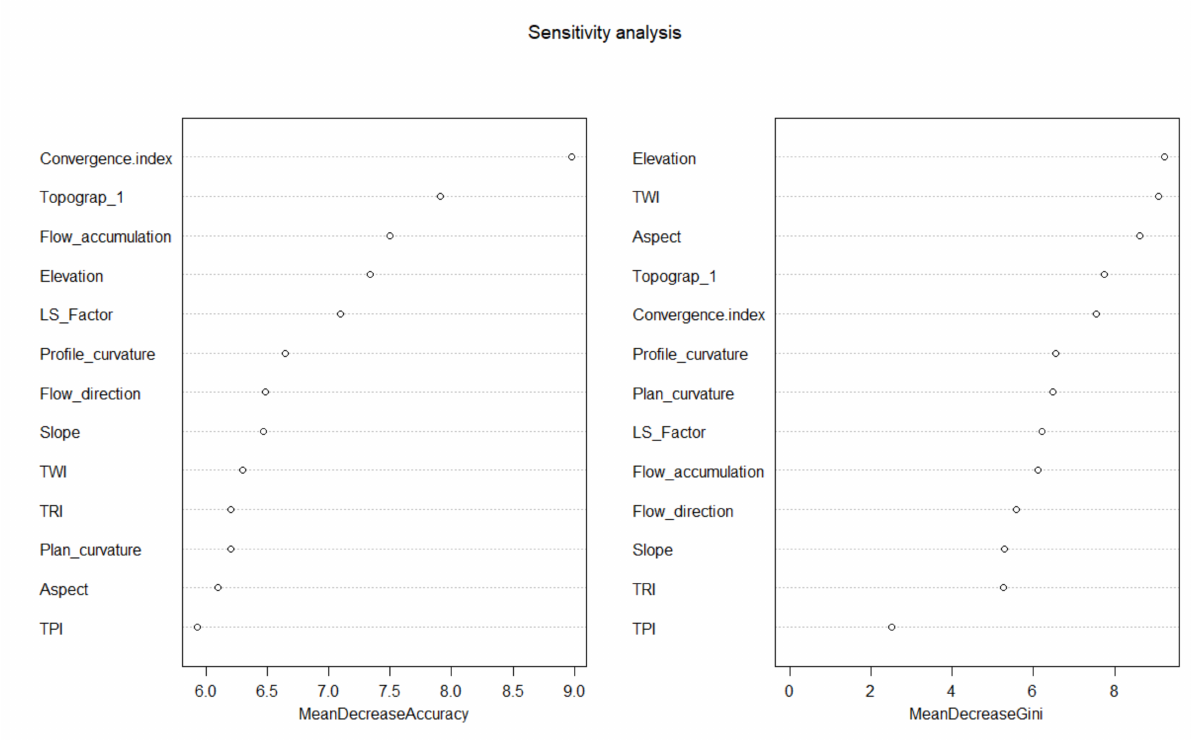
Figure 6. Sensitivity analysis for the best model (AND model) using MDA and